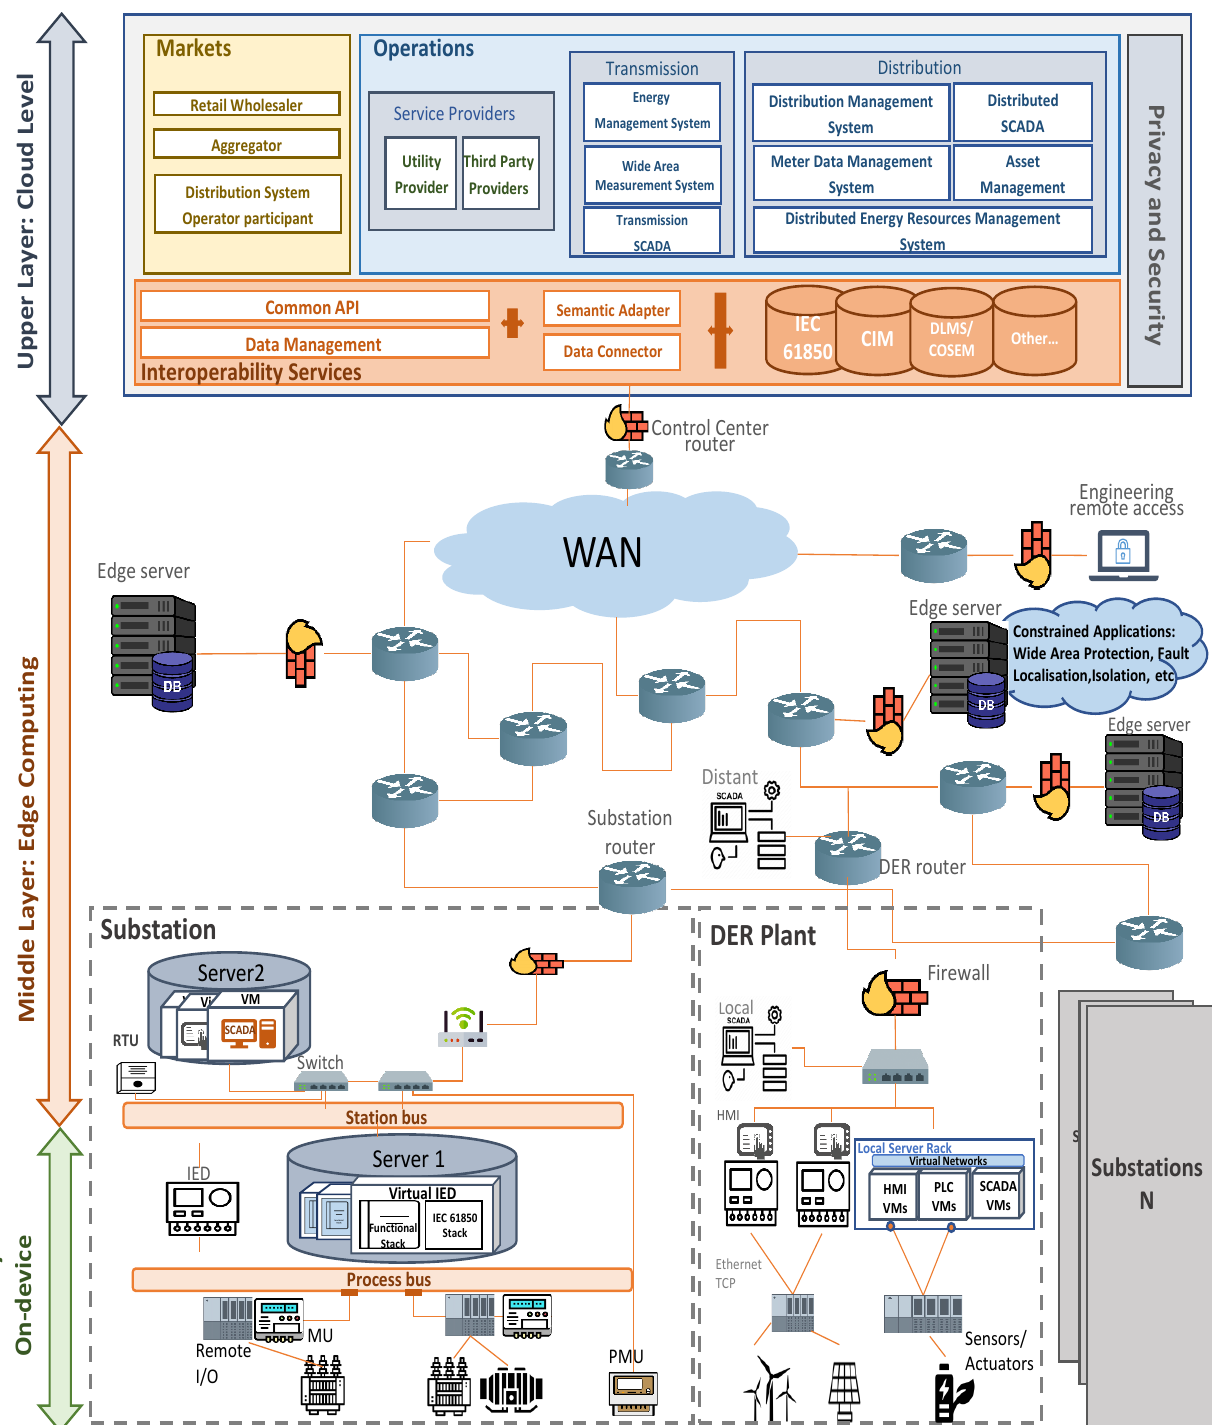
Figure 6. Cloud/Edge Computing Architecture mapped to future PAC systems in Smart Grids based on